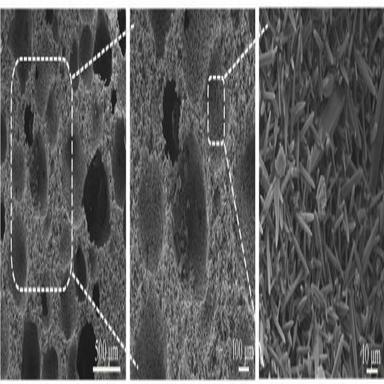
Microstructures of lightweight porous materials with varying AlF3⋅3H2O contents. (a) 0, (b) 3, (c) 6, and (d) and 9 wt%.